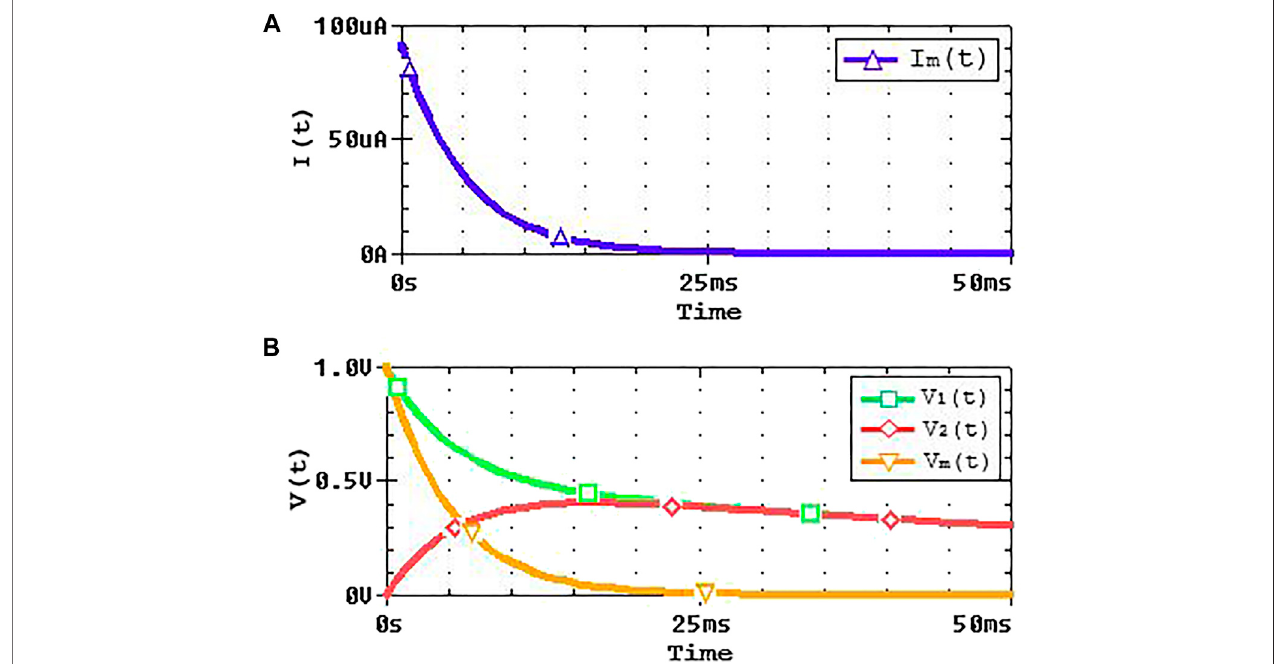
FIGURE 8 | ( A ) Current through the memristor. ( B ) Evolution of V 1 ( t ) and V 2 ( t ) for cells one and two, respectively, and the voltage across the memristor V m ( t ) (cid:1) V 1 ( t ) − V 2 ( t ) .Nocurrent fl owsthroughthememristorwhen V 1 ( t ) (cid:1) V 2 ( t ) ,andthevoltageacrossthememristorisalsozero. V 1 ( t ) and V 2 ( t ) eventuallydecayto zero due to the resistive nature of the